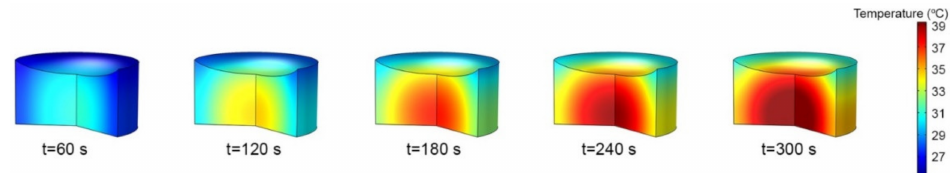
Figure 7. Time evolution of temperature in the solution (100 µ L) of α = 16 m − 1